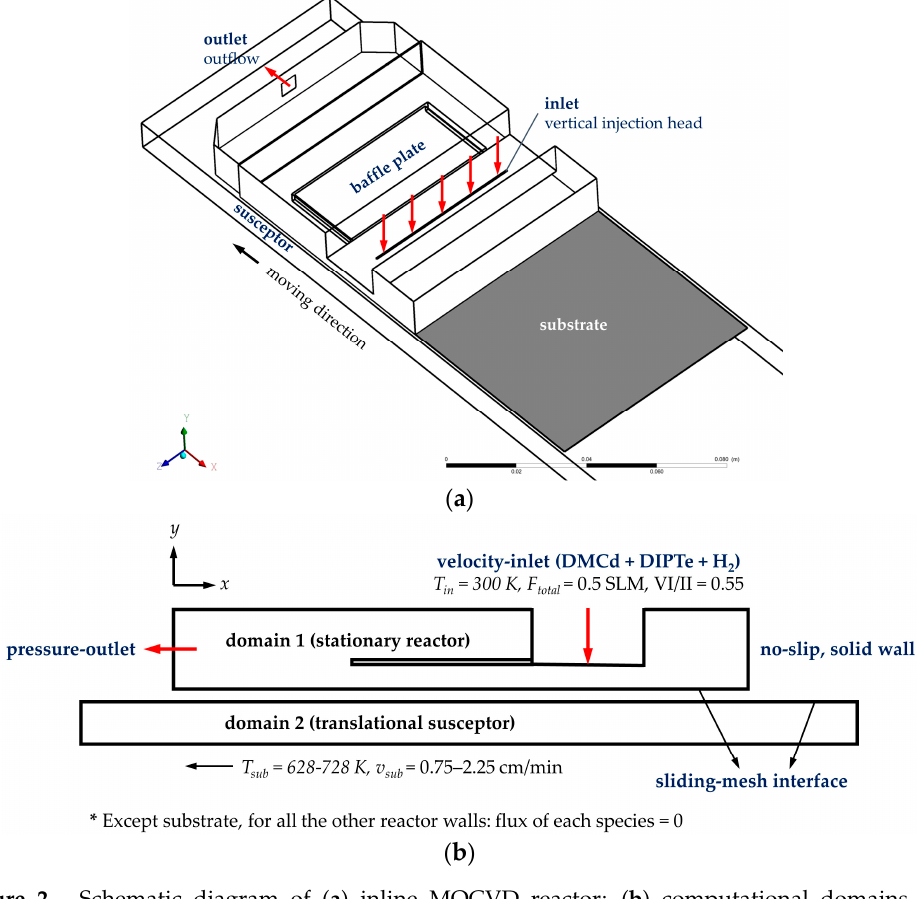
Figure 2. Schematic diagram of ( a ) inline MOCVD reactor; ( b ) computational domains and boundary conditions.